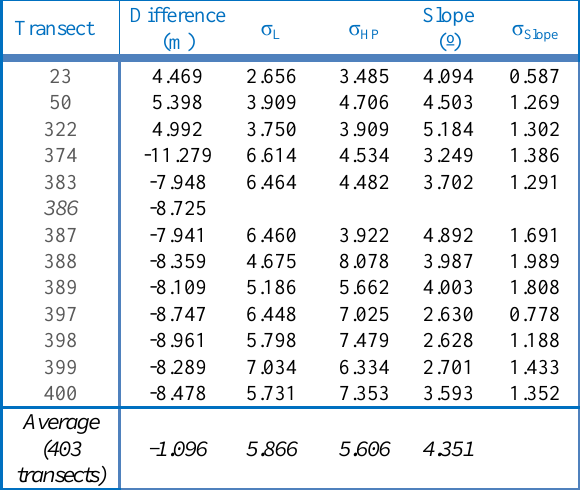
18.54%, transects where absolute differences are greater than